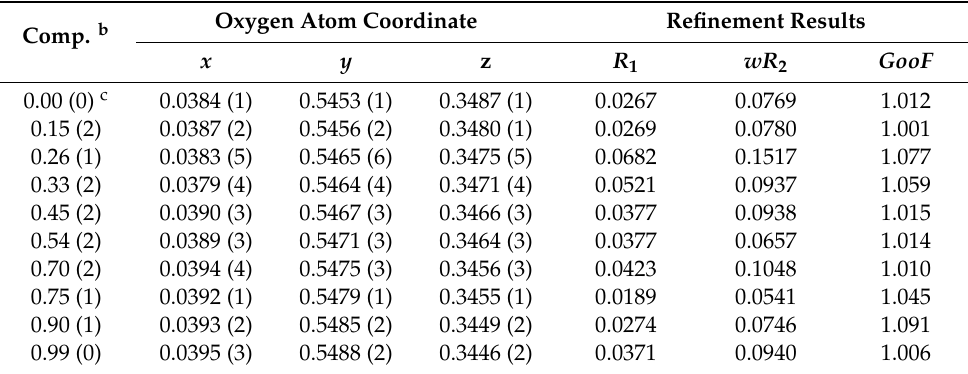
Table 3. Atom fraction coordinate a and refinement